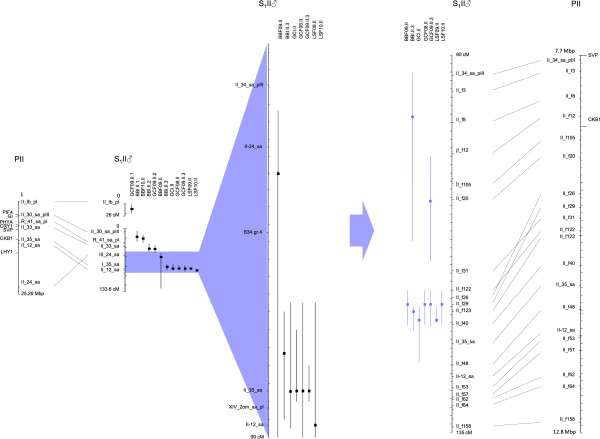
QTL hotspots on LG II for the mapped traits (BB = bud burst, GC = growth cessation and LS = leaf senescence) and alignment to the poplar (P. trichocarpa) physical map. Homologous markers are connected with dotted lines. The positions of candidate genes involved in the photoperiodic pathway and circadian clock are shown on the poplar chromosomes. The regions with increased marker density are shown to the right of the arrows.